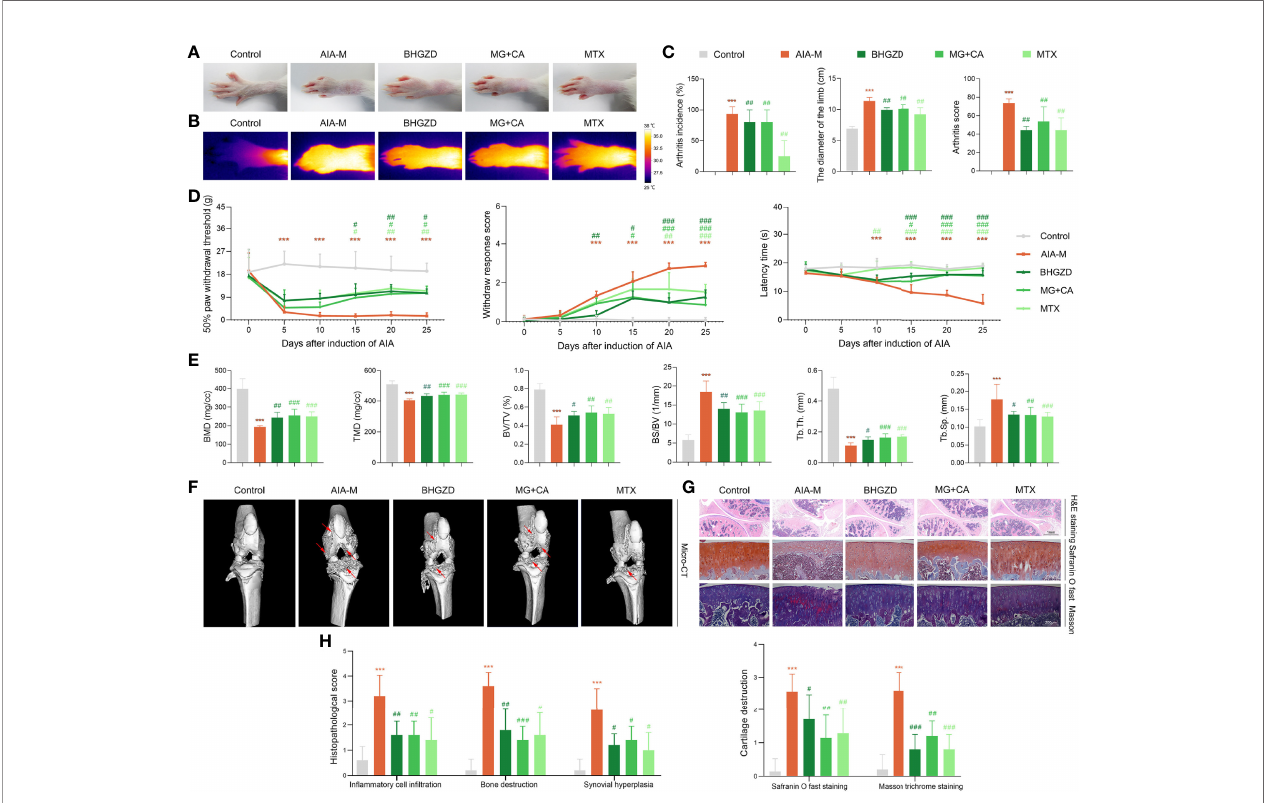
FIGURE 3 | Therapeutic effects of BHGZD, two-BAC combination, and MTX on the severity of arthritis in AIA-M rats (Control, AIA-M, BHGZD, MG+CA, and MTX). (A) Representative images of arthritis. (B) Infrared thermography. (C) Arthritis incidence ( n = 3 per group), the diameter of the limb ( n = 5 per group), and arthritis score on the 27th day after immunization ( n ≥ 4 per group, all experiments were performed in triplicate). (D) The pain thresholds (mechanical-, acetone-, and thermal-induced hyperalgesia, n ≥ 4 per group, all experiments were performed in triplicate). (E) Quantitative micro-computed tomography (micro-CT) analysis of bone mineral density (BMD), tissue mineral density (TMD), bone volume/tissue volume (BV/TV), bone surface/bone volume (BS/BV), trabecular separation (Tb.Sp), and trabecular thickness (Tb.Th) on the 31st day after immunization ( n ≥ 5 per group, all experiments were performed in triplicate). (F) Representative micro-CT images of knee joints showing bone erosion levels (the red arrow indicates the position of the bone destruction). (G) Pathological changes in the knee joints using hematoxylin and eosin (H&E, scale bar represents 1 mm), safranin O fast green (scale bar represents 200 m m), and Masson trichrome staining (scale bar represents 200 m m) in different groups ( n = 5 per group). (H) Quantitative analysis of H&E staining in in fl ammatory cell in fi ltration, bone destruction, and synovial hyperplasia. Cartilage destruction of safranin O fast, and Masson trichrome staining ( n = 5 per group). Data are expressed as the mean ± SD. ***, p < 0.001, comparison with the normal control group; #, ##, ###, p < 0.05, p < 0.01, p < 0.001, respectively, comparison with the AIA-M model